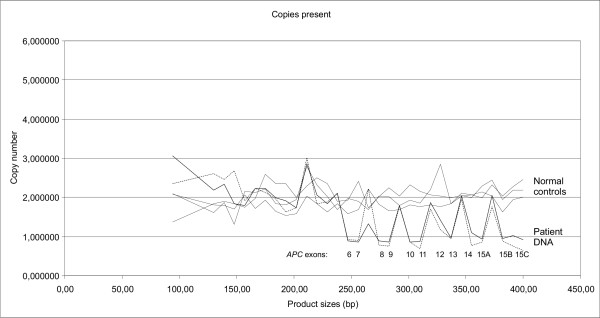
Results from MLPA experiment. Chart of normalized copy number of the MLPA probes target sequences, representing APC exons and control regions on other chromosomes, versus size of amplified products. Two different DNA samples from the same patient present only one copy per cell for exons 6 to 15 supporting the presence of a large APC deletion from one chromosome.